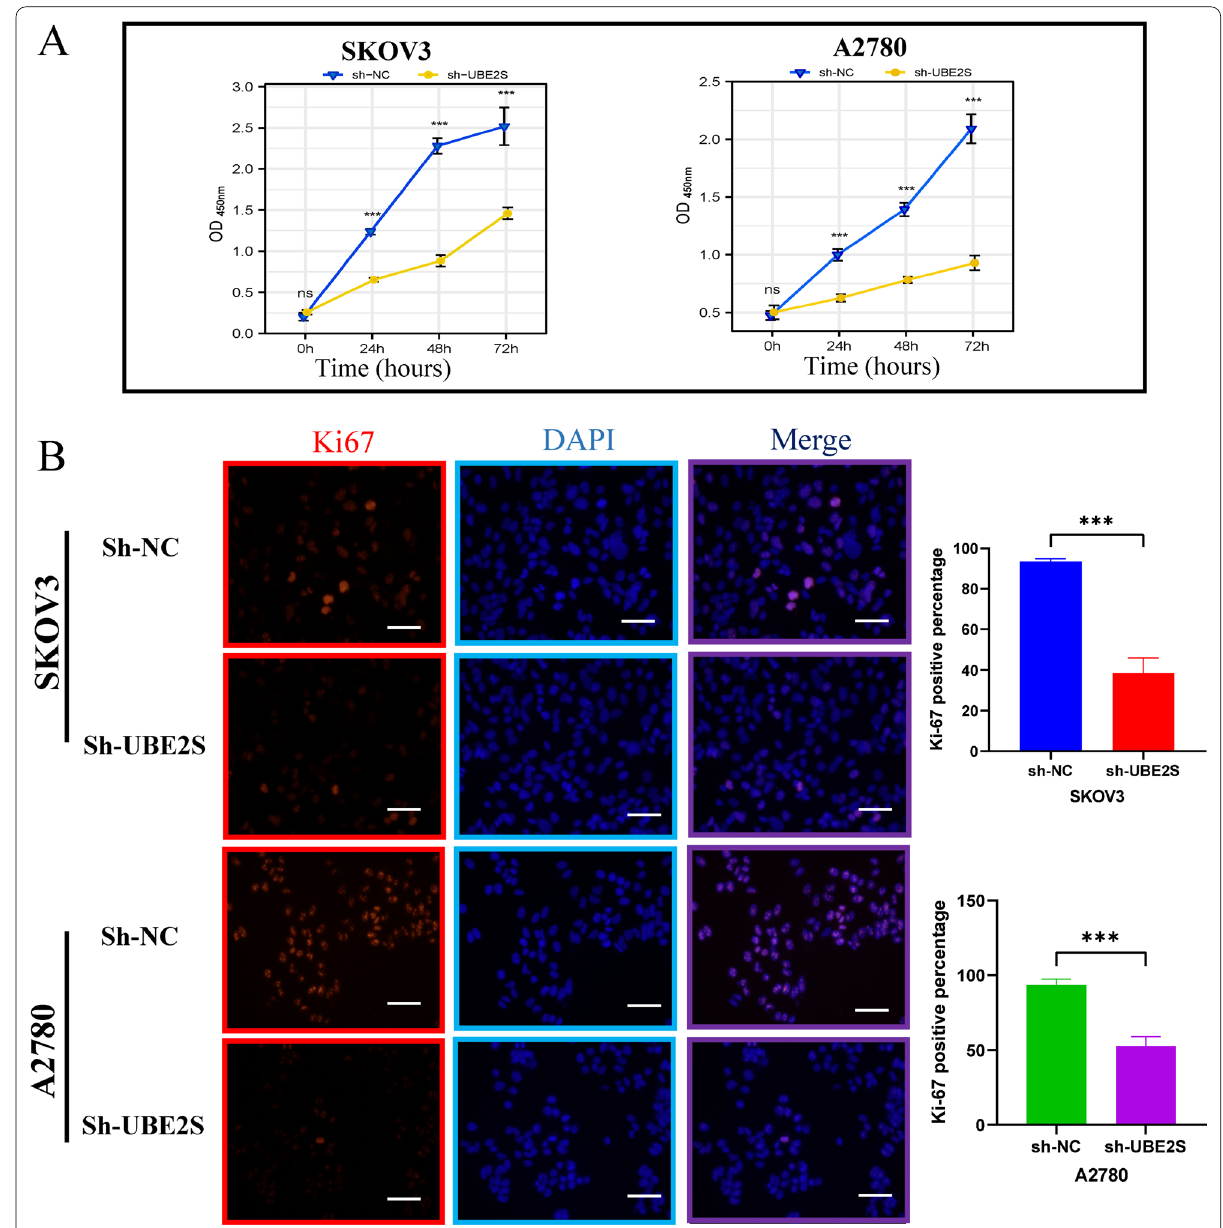
Fig. 7 The impact of UBE2S gene knockdown on the proliferation of OV cells. A CCK8 experiment results of A2780 and SKOV3 cell lines after cell transfection. The OD values measured at 450 nm wavelength at 0 h, 24 h, 48 h, and 72 h were displayed, which represented the cell proliferation rate. B Ki-67 immunofluorescence staining of A2780 and SKOV3 cell lines after cell transfection. Ki67 red staining represents cells in a state of proliferation. The DAPI blue nuclear staining represents total living cells. Merge represents the merging of two images. Related statistical graphs were also